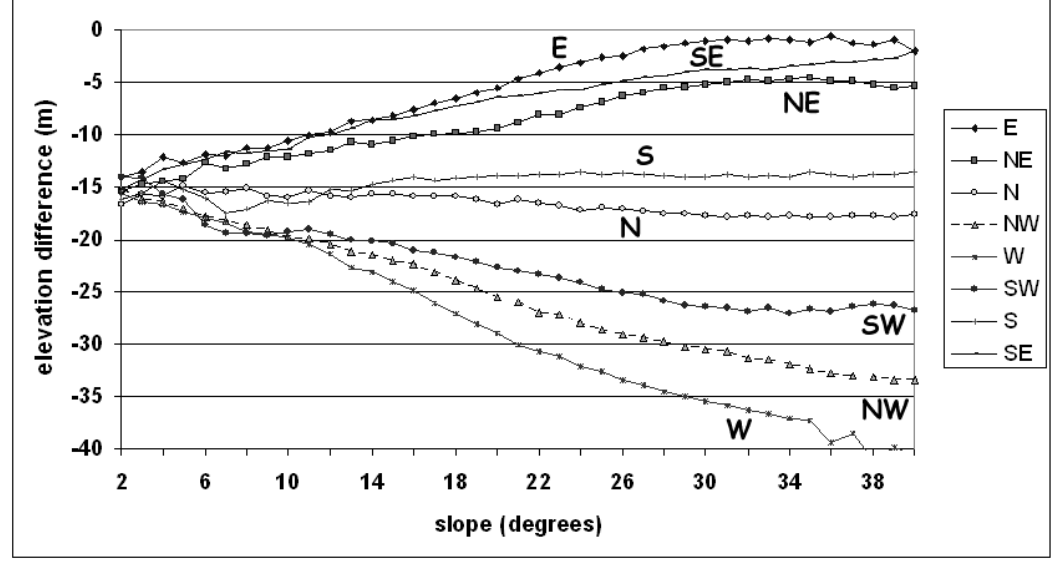
Figure 8. The mean elevation difference versus 1 o slope intervals per geographic direction.